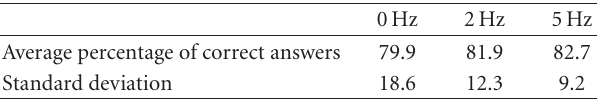
Table 2: Percentage of correct answers according to frequencies.